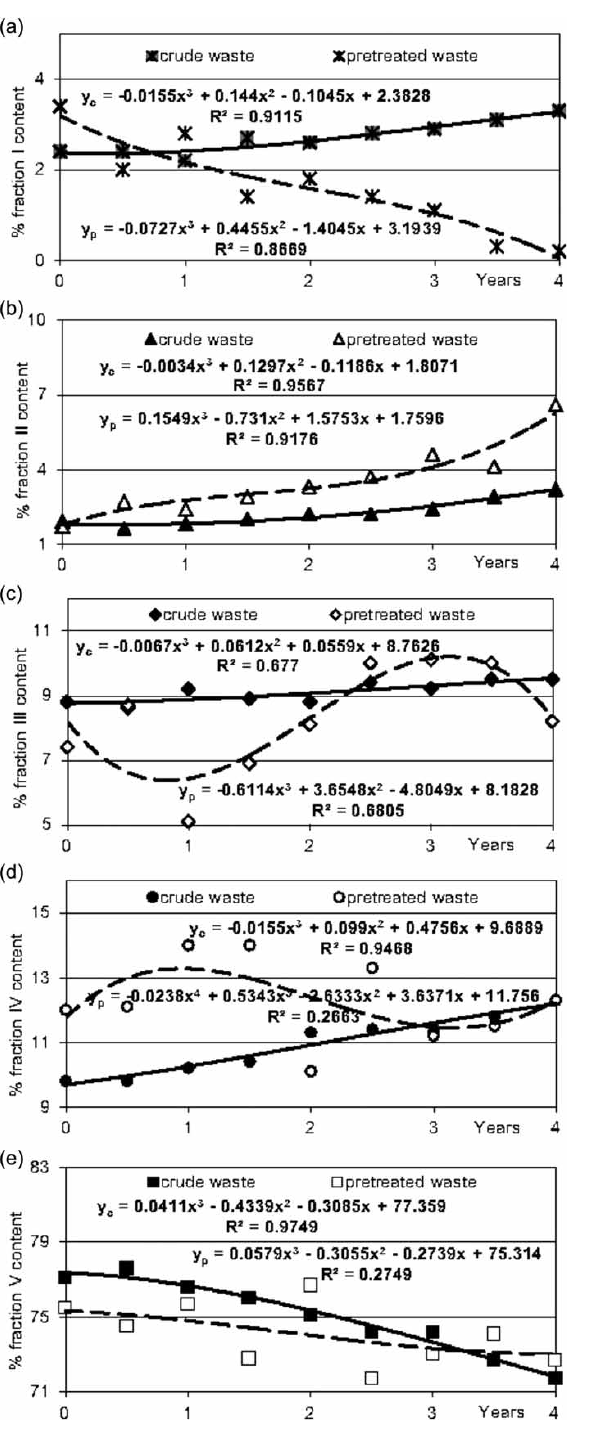
Fig. 4. Changes in the fractional content of nickel (Ni) in the surface layer of soil from the experimental plots irrigated and fertilized with mixed wastewaters from an oleo-chemical factory (cid:1) defatted raw (solid line of the trend (cid:1) y c ) and pretreated (broken line of the trend (cid:1) y p ) (C 0(Ni) (cid:1) 9.3 9 0.6 mg/kg d.m.). Individual fractions are given in diagrams: (a) fraction I (cid:1) exchanged, (b) fraction II (cid:1) carbonate, (c) fraction III (cid:1) connected with hydrated oxides of manganese and iron, (d) fraction IV (cid:1) organic, (e) fraction V (cid:1) the